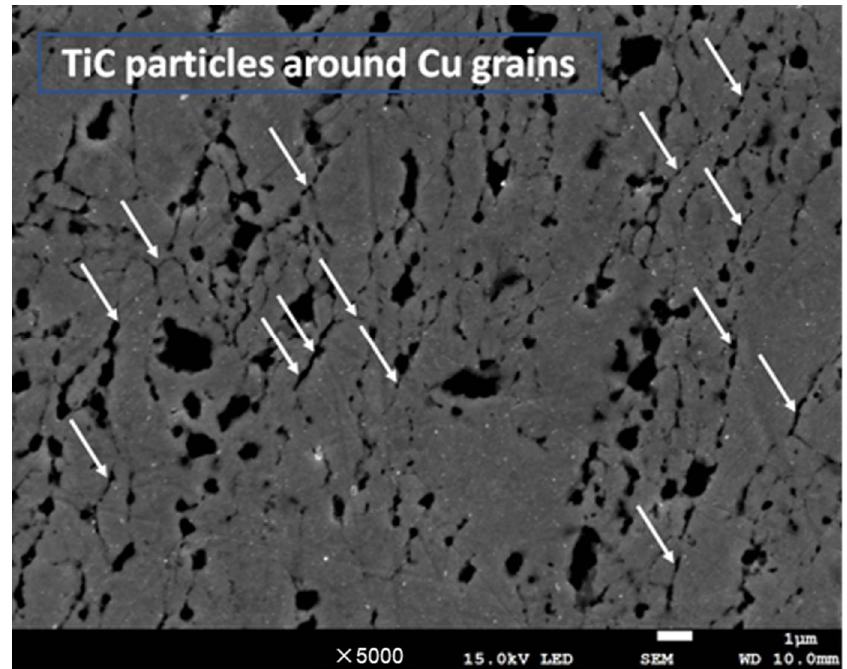
Figure 12. Spot white arrows indicate TiC around Cu grains.